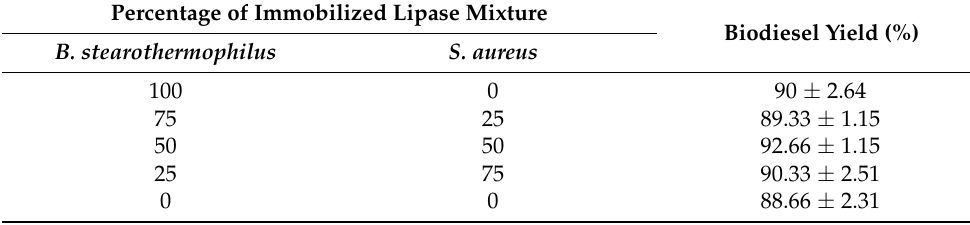
Table 2. Effect of CaCO 3 -immobilized individual and mixed lipases on the transesterification of waste cooking oil (WCO) under the following experimental conditions: enzyme loading 1% wt, 1:6 oil to methanol molar ratio, 5% water content, a 45 ◦ C temperature reaction, a 24 h reaction time and 150 rpm agitation. Values are the mean of the three replicates ± SD. Percentage of Immobilized Lipase